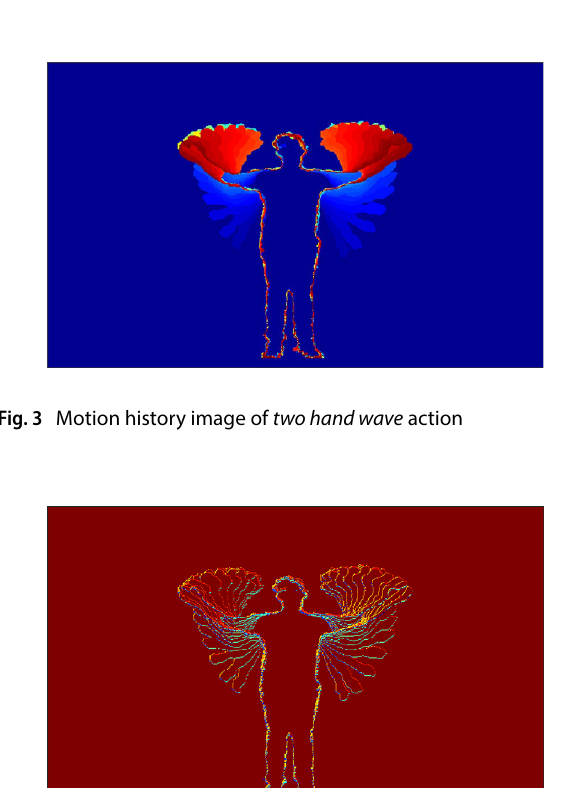
Fig. 2 Architecture visualization of our proposed framework